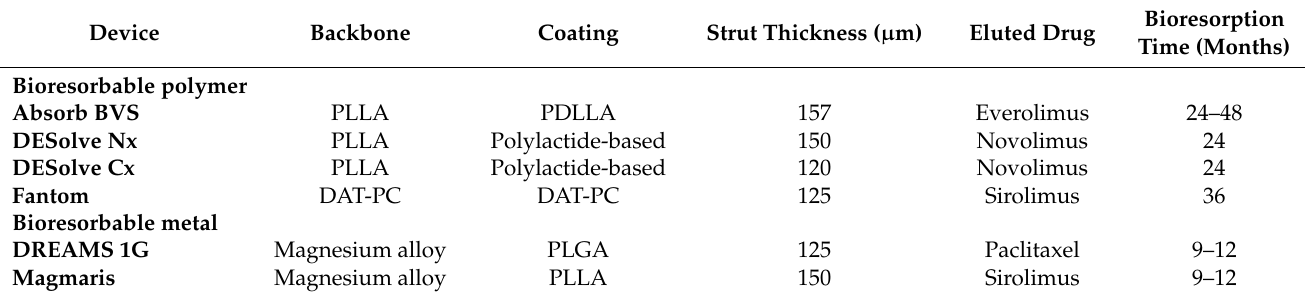
Table 4. Main features of bioresorbable